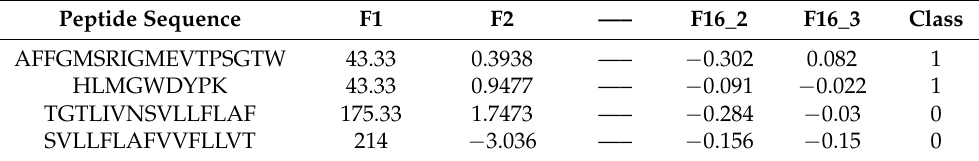
Table 3. Glimpse of the